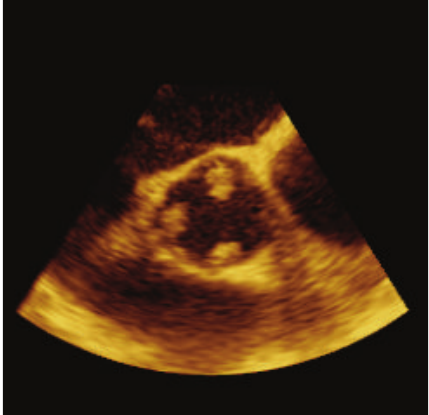
Figure 1: 2D aortic valve short-axis, transesophageal view display- ing fungal vegetation on all three aortic valve